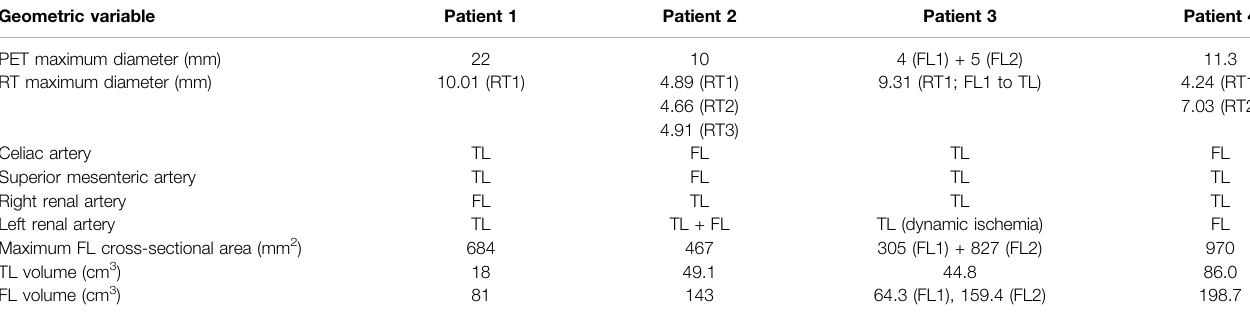
TABLE 1 | Aortic dissection morphologic measurements of interest for the four